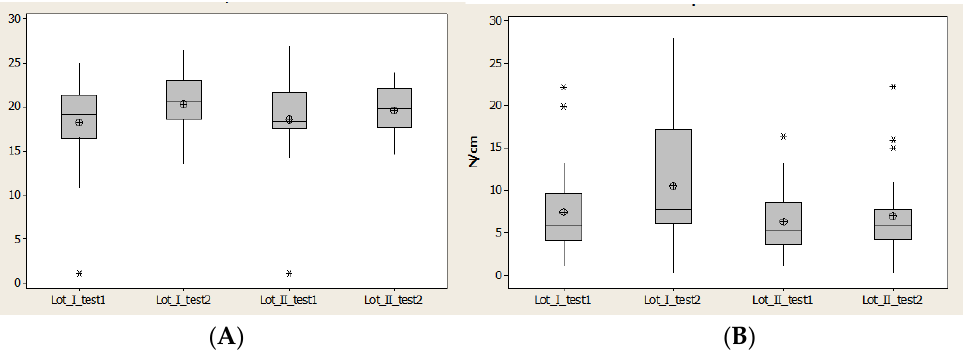
Figure 10. Plantar region medial heel: ( A ) contact area, ( B ) Pmax distribution. * Small distribution, ** High distirbution.